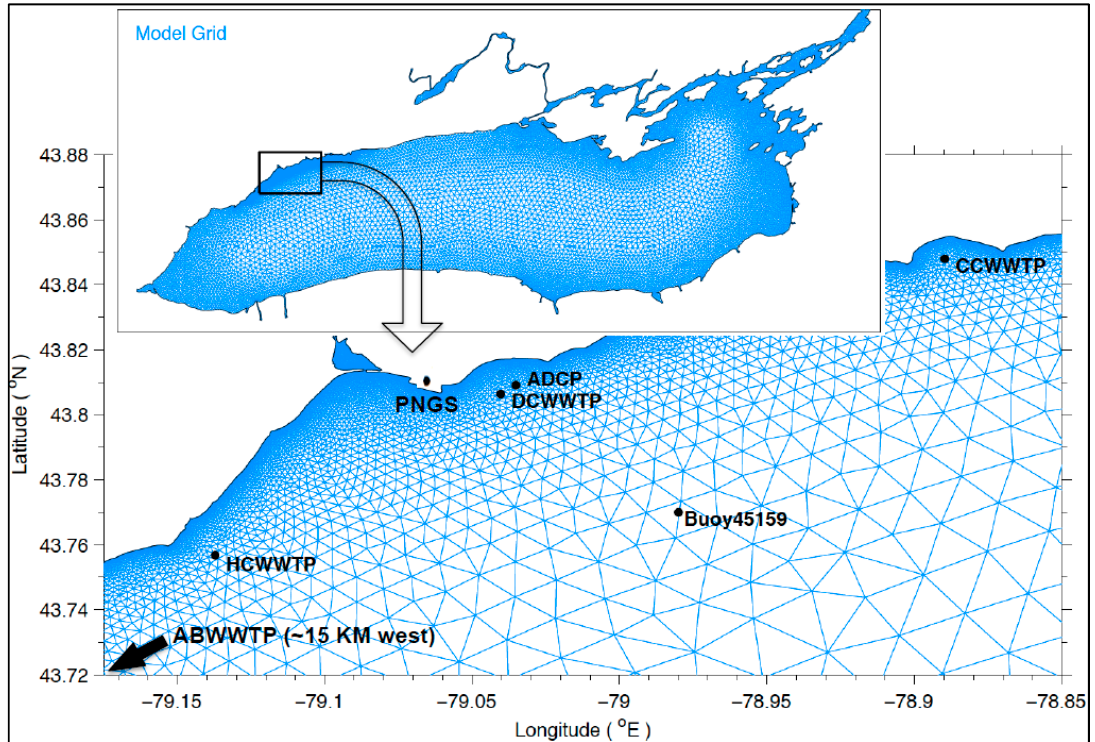
Figure 3. Model mesh for Lake Ontario with additional detail presented for the immediate study area.